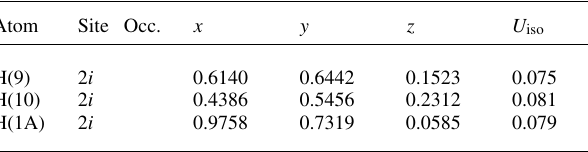
Table 2. Atomic coordinates and displacement parameters (in Å 2 ) .